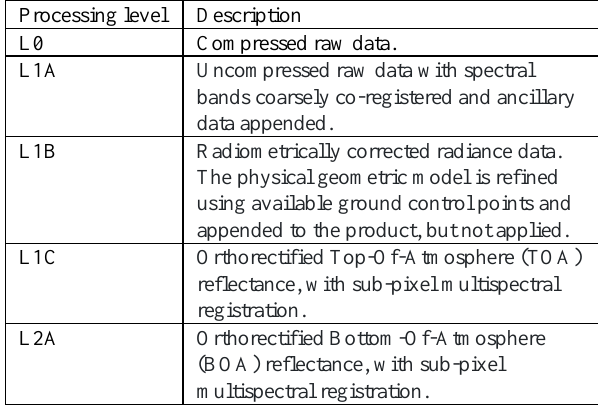
Table 1: Sentinel-2 Processing levels